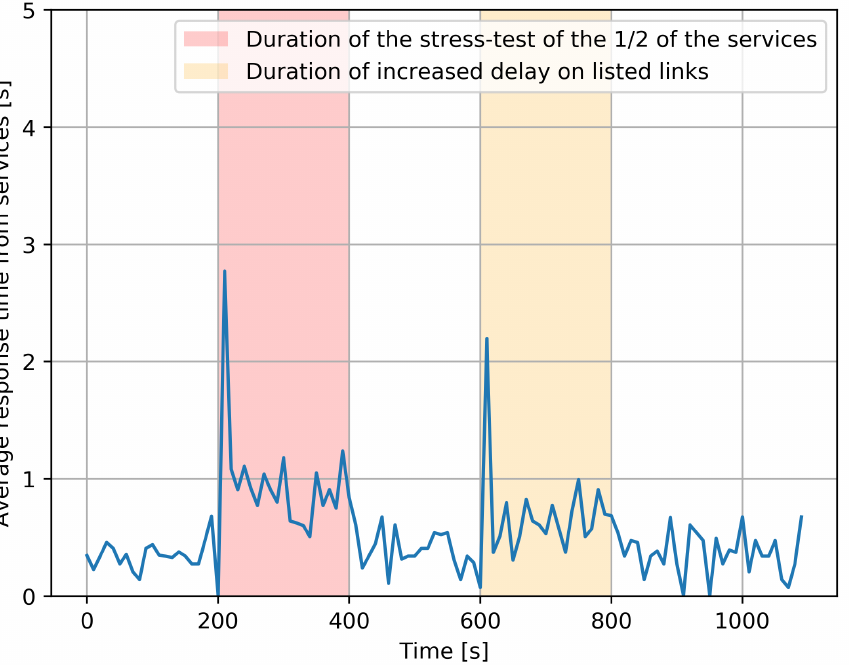
Figure 5. The average response time experienced by all clients for the services, measured over some 1000 s, averaged over five distinct experiments with identical